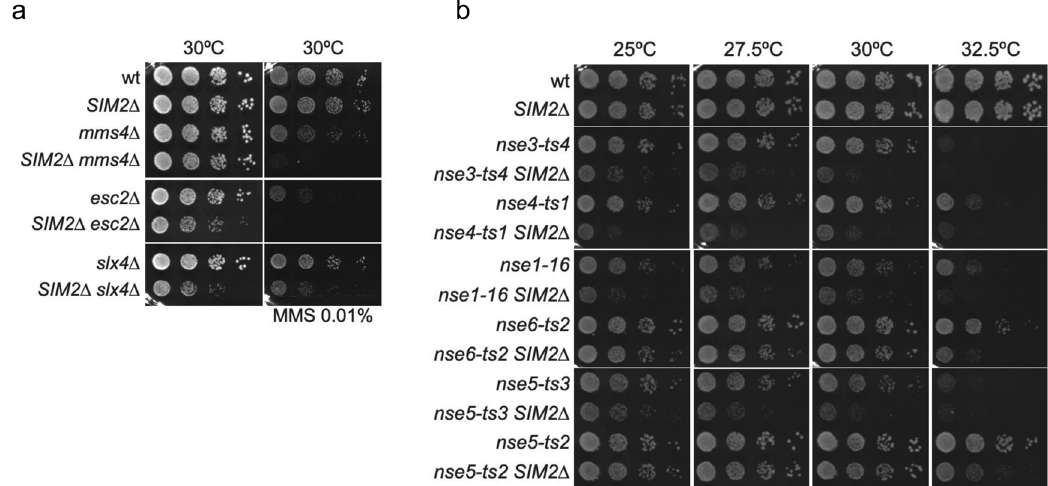
Fig. 3 Analysis of nse2-SIM2 Δ mutants in yeast. a Growth test analysis of nse2-SIM2 Δ ( SIM2 Δ ) cells in combination with mms4 Δ , esc2 Δ and slx4 Δ ; 10-fold serial dilutions of liquid cultures were spotted in YPD in the presence or not of MMS 0.01% and incubated at 30 °C for 48h. b Growth test analysis of nse2- SIM2 Δ ( SIM2 Δ ) cells in combination with the indicated Smc5/6 complex alleles; 10-fold serial dilutions of liquid cultures were spotted in YPD and incubated at the indicated temperatures for